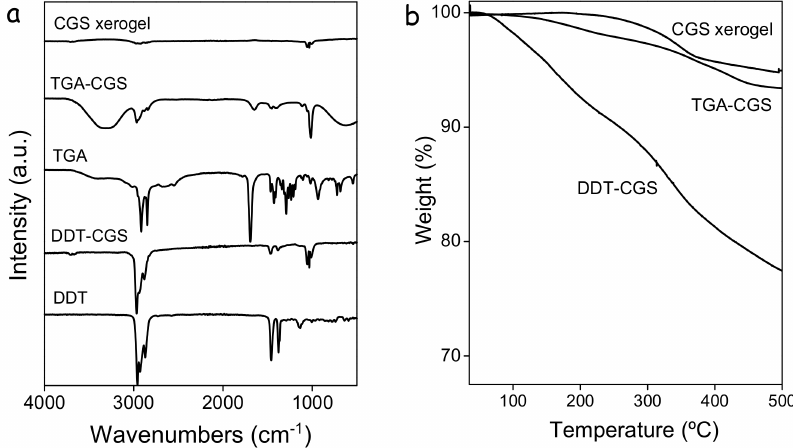
Figure 2. ( a ) from bottom to top: FTIR spectra of DDT; as-prepared CGS NCs (DDT-CGS); TGA; NCs functionalized with TGA (TGA-CGS); and the NC xerogel obtained by exposing TGA-NCs to the oxidant solution and naturally drying them; ( b ) thermogravimetric profile of the DDT-CGS NCs, TGA-CGS NCs and CGS xerogel.